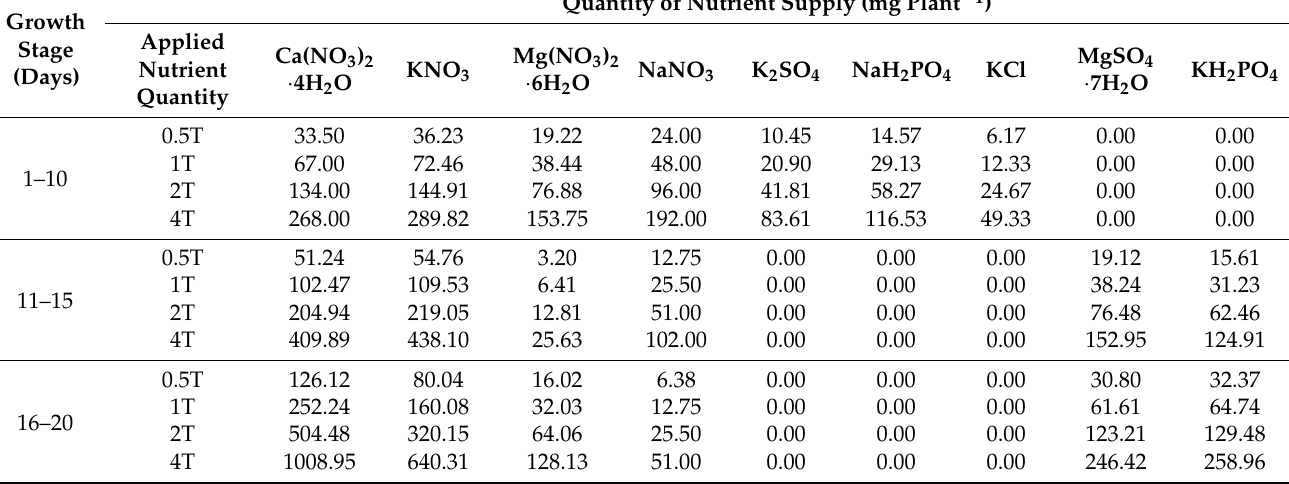
Table 1. Fertilization design of Experiment